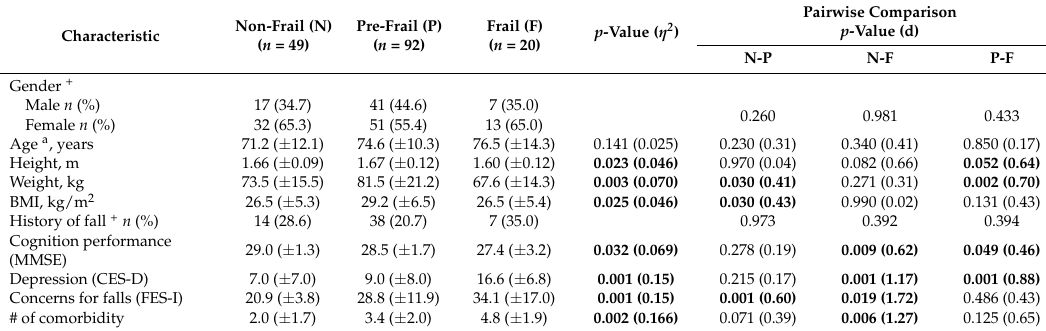
Table 2. Demographic and clinical characteristic of